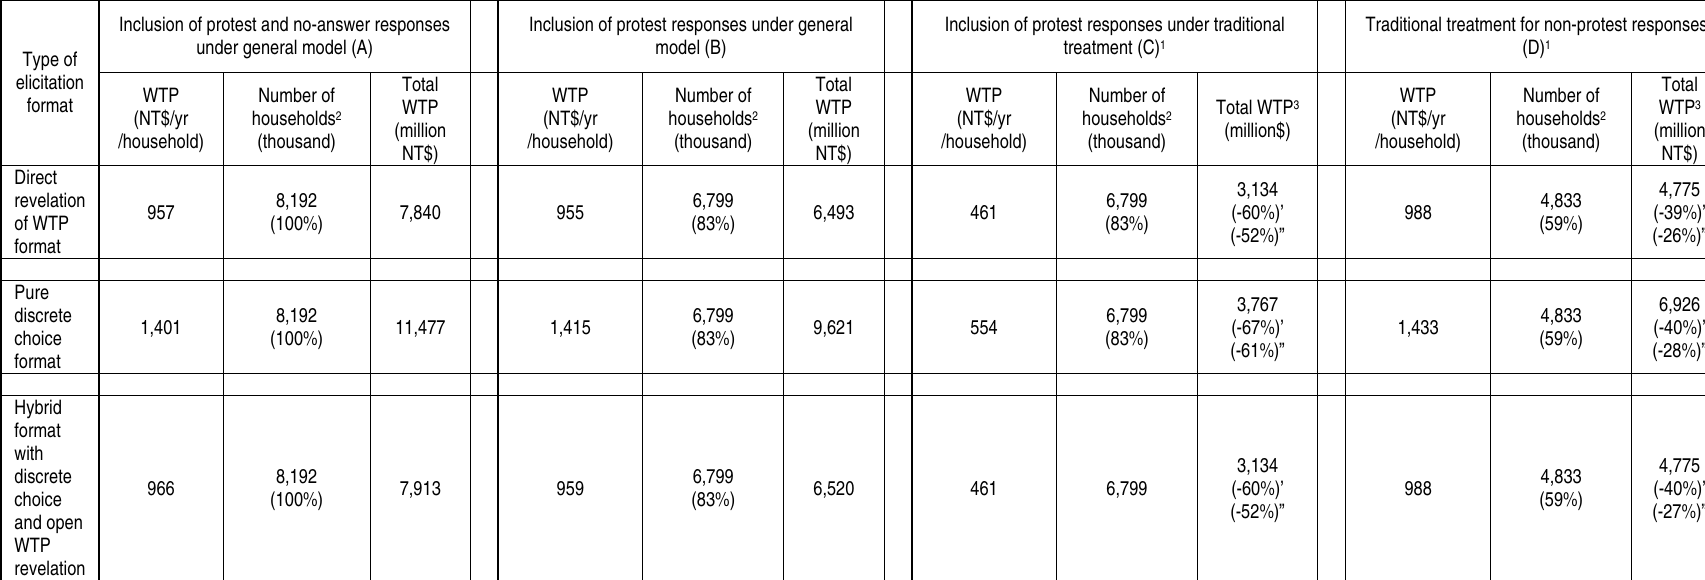
Table 4. Comparison of total WTP from traditional treatment of protest and no-answer responses and from general model under different types